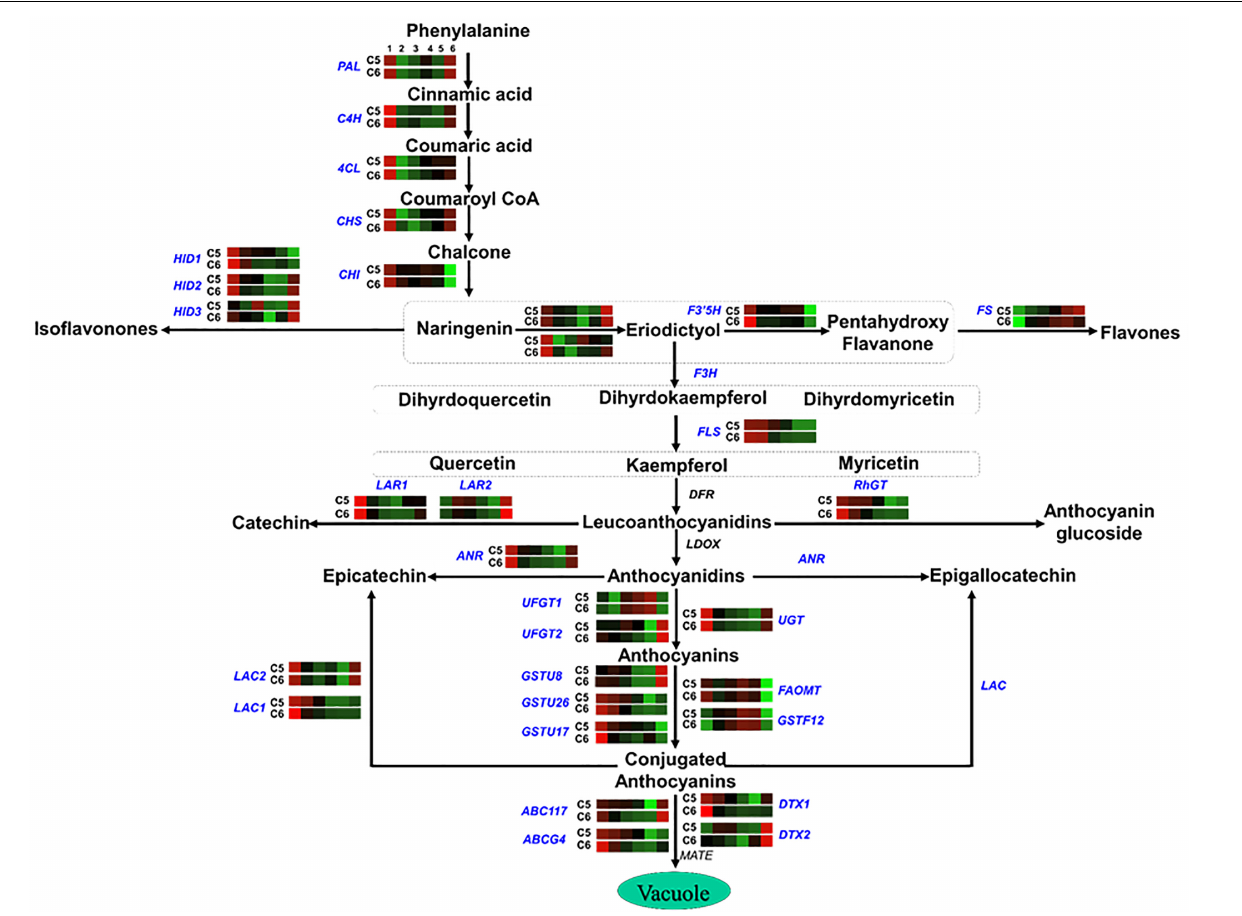
FIGURE 7 | Flavonoid pathway. The colored boxes show the accumulation pattern of genes involved in flavonoid pathway that were assessed by qPCR at different berry developmental stages, including fruit-set (1), prevéraison (2), véraison (3), postvéraison (4), ripe-skin/flesh (5), and ripe-seeds (6). Red boxes indicate higher levels of expression, and green boxes indicate lower expression levels. The color brightness is directly proportional to the expression ratio, according to the color scale. CHS , chalcone synthase; CHI , chalcone isomerase; HID , 2-hydroxyisoflavanone dehydratase; F3H , flavonoid 3 (cid:48) -monooxygenase; F3 (cid:48) 5 (cid:48) H , flavonoid 3 (cid:48) 5 (cid:48) -hydroxylase; FS , flavonol synthase; FLS , flavonol sulfotransferase; LAR , leucoanthocyanidin reductase; RhGT , anthocyanidin 5,3- O -glucosyltransferase; ANR , anthocyanidin reductase; UGT , gallate 1-beta-glucosyltransferase; UFGT , anthocyanidin 3- O -glucosyltransferase; OMT/FOMT , flavonoid 3,5-methyltransferase; GST , glutathione S-transferase; ABC , ATP-binding cassette transporter; DTX , protein